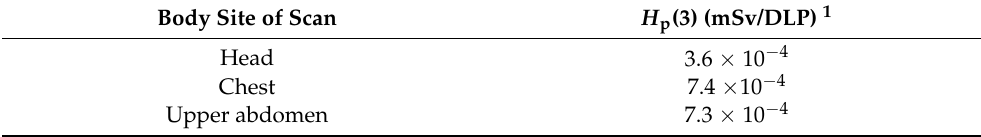
Table 3. H p (3) of the medical staff per DLP in normalised position of 75 cm (without Pb